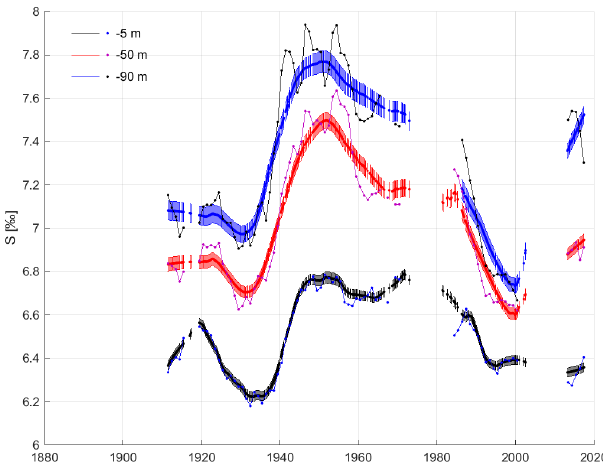
Figure 8. Average seawater salinities in Utö at − 5, − 50 and − 90m depths. For details, see Fig. 7.